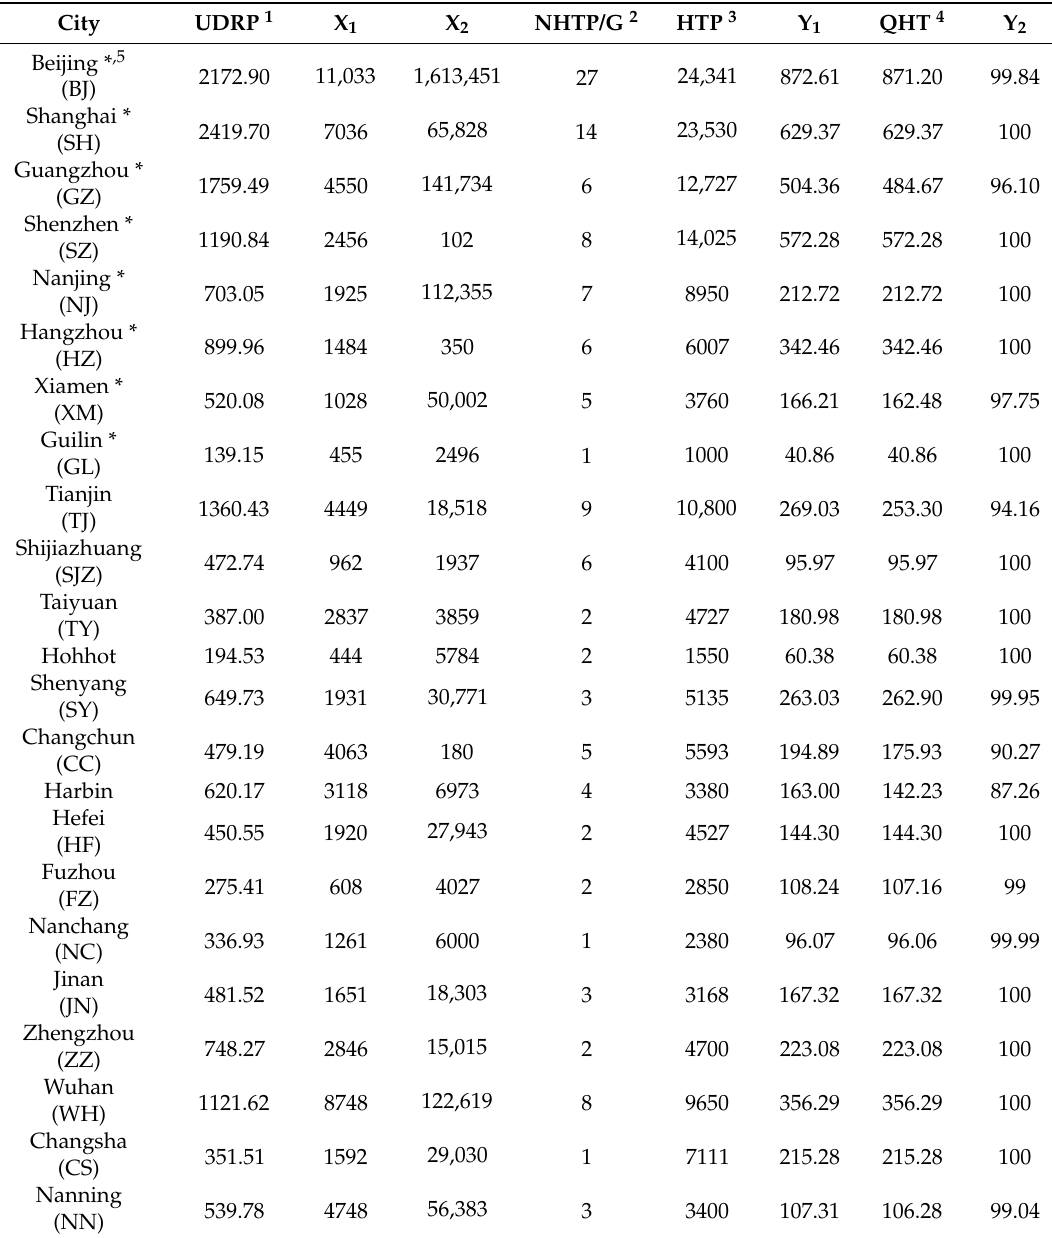
Table 2. Overview of 33 typical cities in